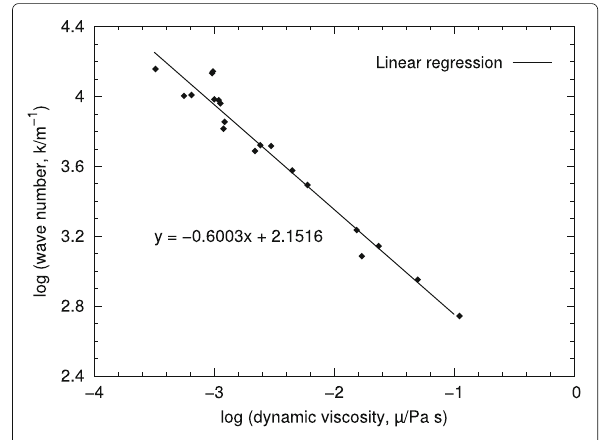
Fig. 17 log μ versus log k of various liquids in Table 7